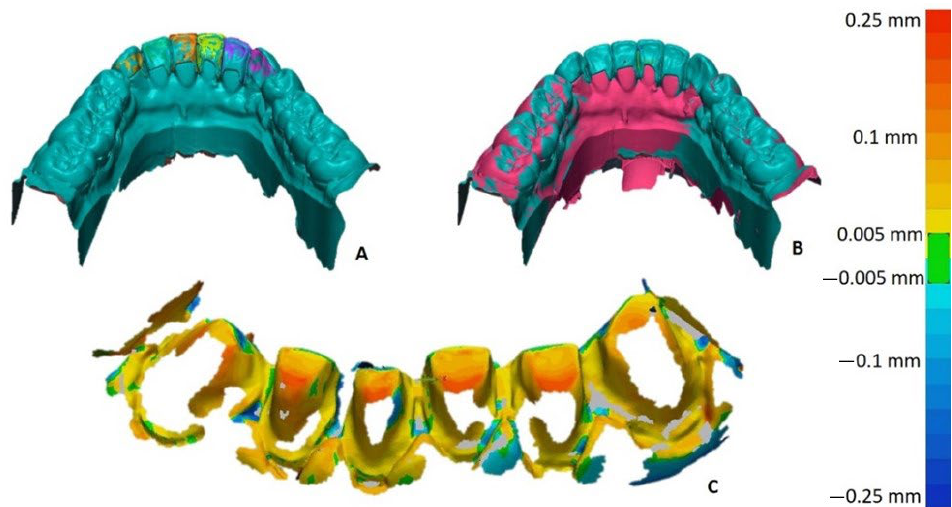
Figure 4. ( A ) A scan of each single restoration (multicolor) with the interior surface matched with the scan of restorations in situ (blue); ( B ) scan of the restorations in situ (blue) matched with the scan of the preparation (red); ( C ) heat map of the distances between the interior surface of each LCM restoration and corresponding preparation surface, representing the bottom adaptation.